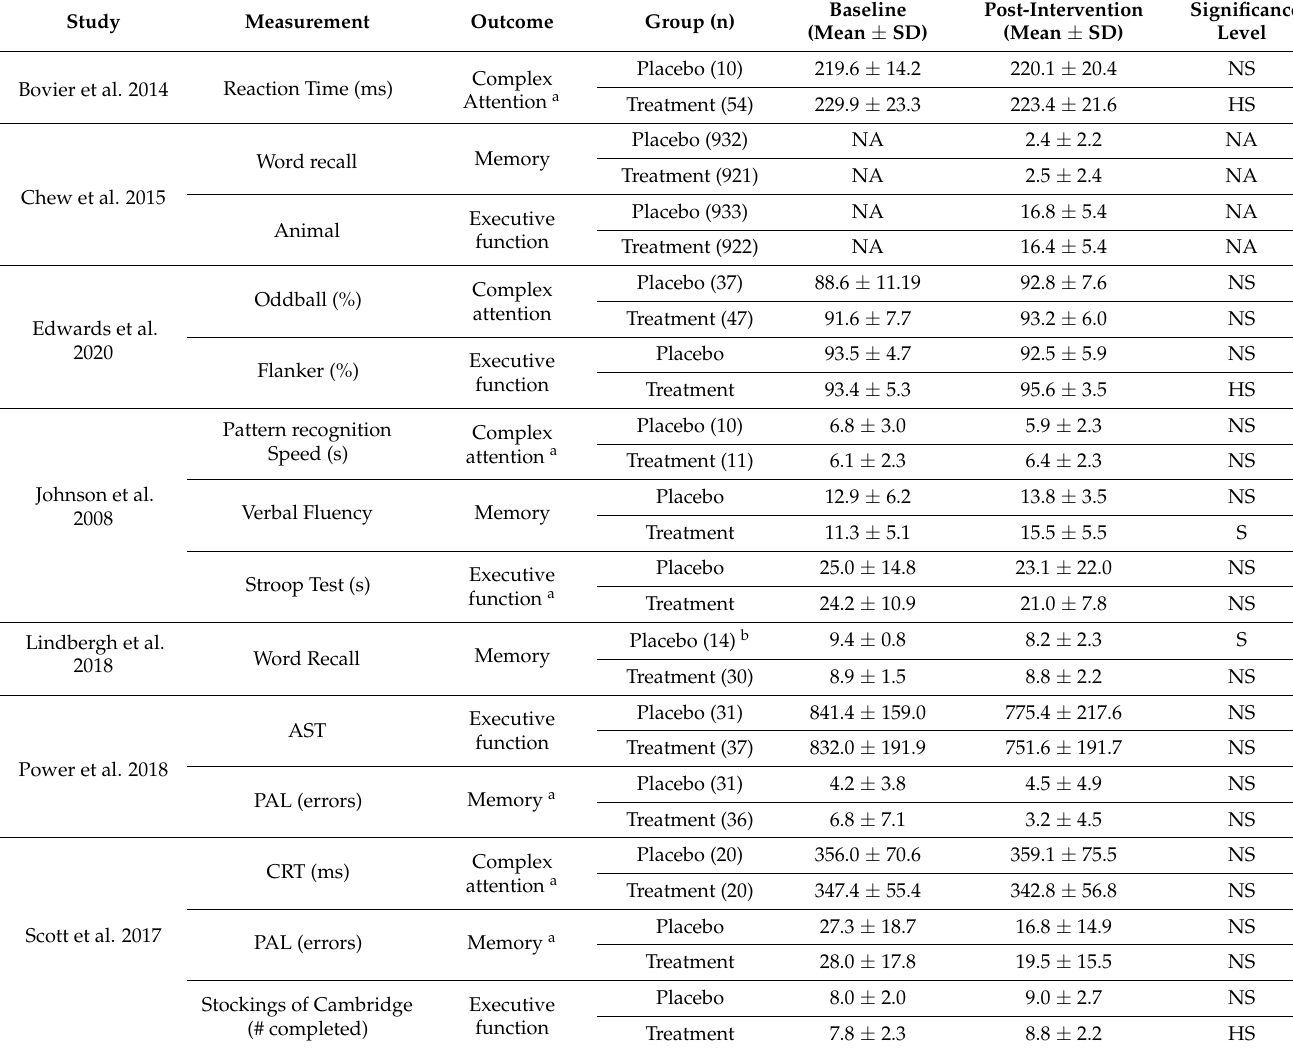
a Lower scores are better. b Placebo group showed a statistical trend toward decline. Abbreviations: AST (attention switching task), CRT (choice reaction time), PAL (paired associates learning), NA (not available), NS (not significant), S (significant, p < 0.01) and HS (highly significant, p <